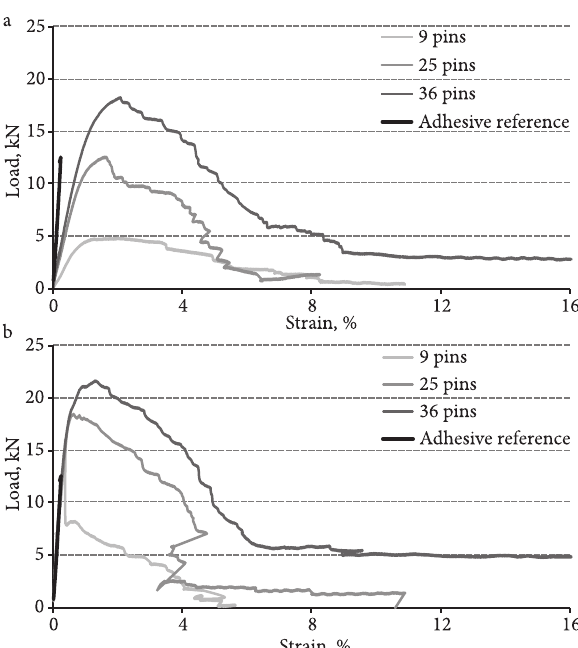
Fig. 6. Shear stress-strain diagrams of the tested single-lap joints: a – mechanically fastened samples; b – hybrid